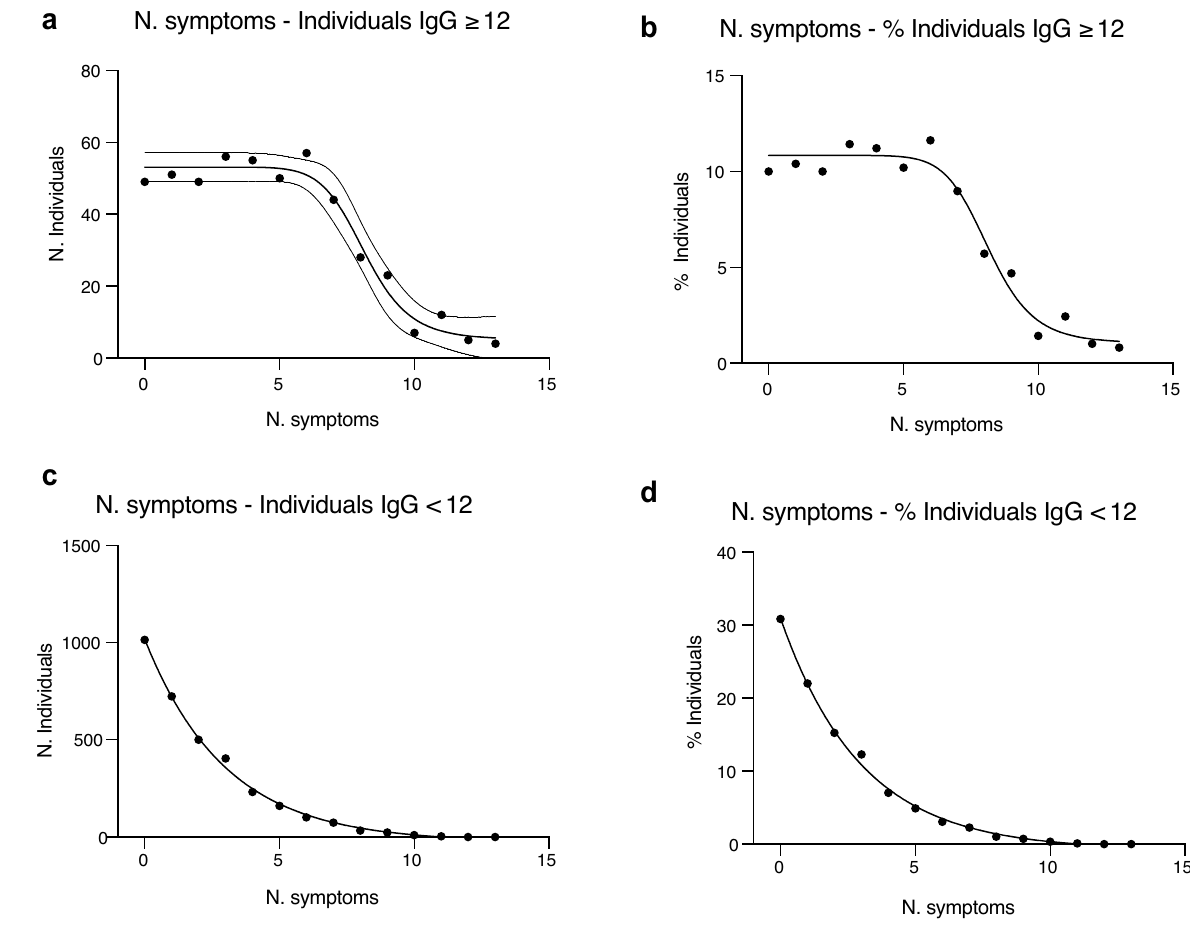
Figure 3. Distribution of the IgG ≥ 12 and IgG < 12 populations versus the number of symptoms. ( a , b ) Distribution of the IgG positive individuals (IgG ≥ 12 AU/mL) as number of individuals ( a ) or percentage of the population ( b ) versus the number of self-reported symptoms. The curve that best interpolated the data was a sigmoidal, four parameter logistic curve whereby X is the number of symptoms (R 2 = 0.97). ( c , d ) Distribution of the IgG negative individuals (IgG < 12 AU/mL) as number of individuals ( c ) or percentage of the population ( d ) versus the number of self-reported symptoms. The curve that best interpolated the data was exponential (R 2 = 0.9975).